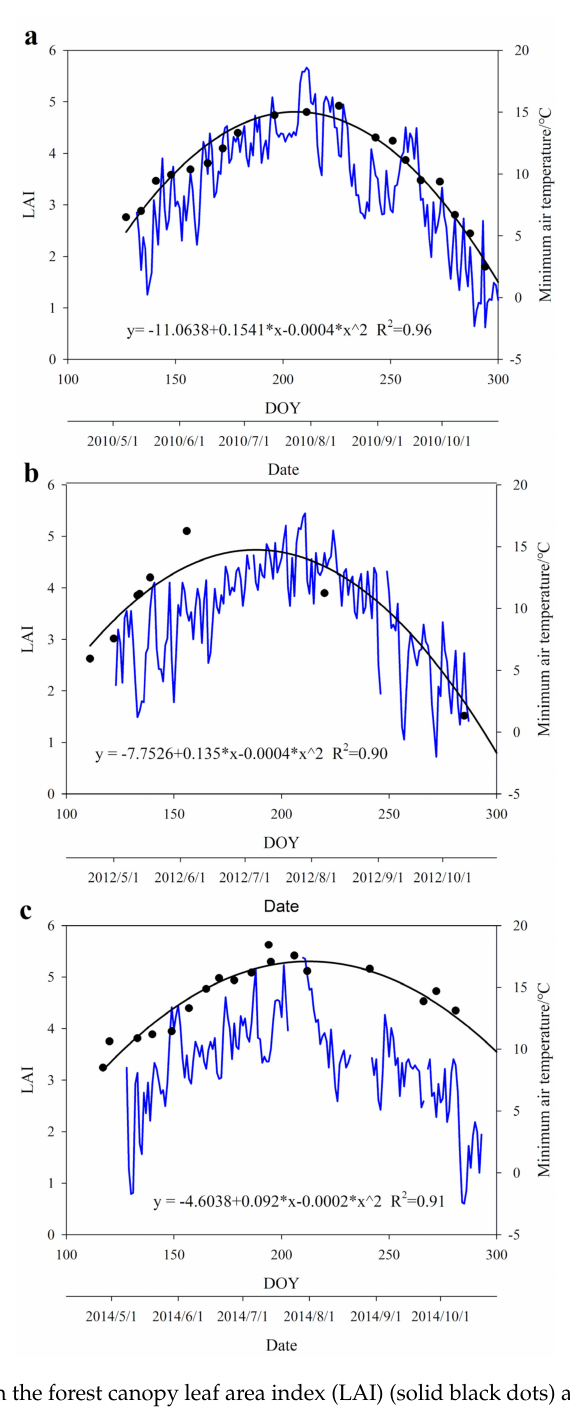
Figure 3. Variations in the forest canopy leaf area index (LAI) (solid black dots) and daily minimum air temperature (solid blue line) in the growing seasons of 2010 ( a ), 2012 ( b ), and 2014 ( c ). The LAI-DOY (day of year) regression relation (solid black line) fits with the binomial